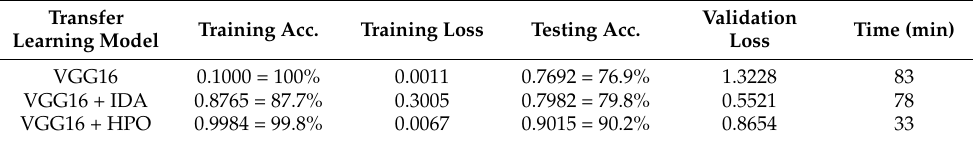
Table 8. Summary of CNN results. Transfer Learning